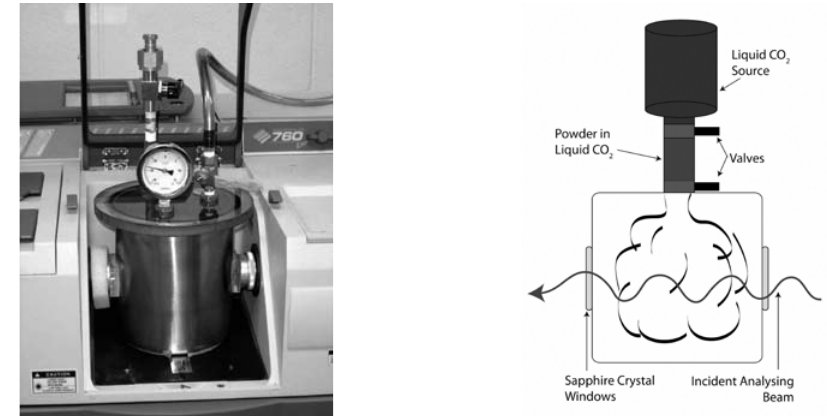
The air dispersion chamber for the FTIR. A) The air dispersion chamber when positioned in the FTIR. B) A schematic diagram of the chamber showing the laser path through an aerosol cloud produced in the chamber.